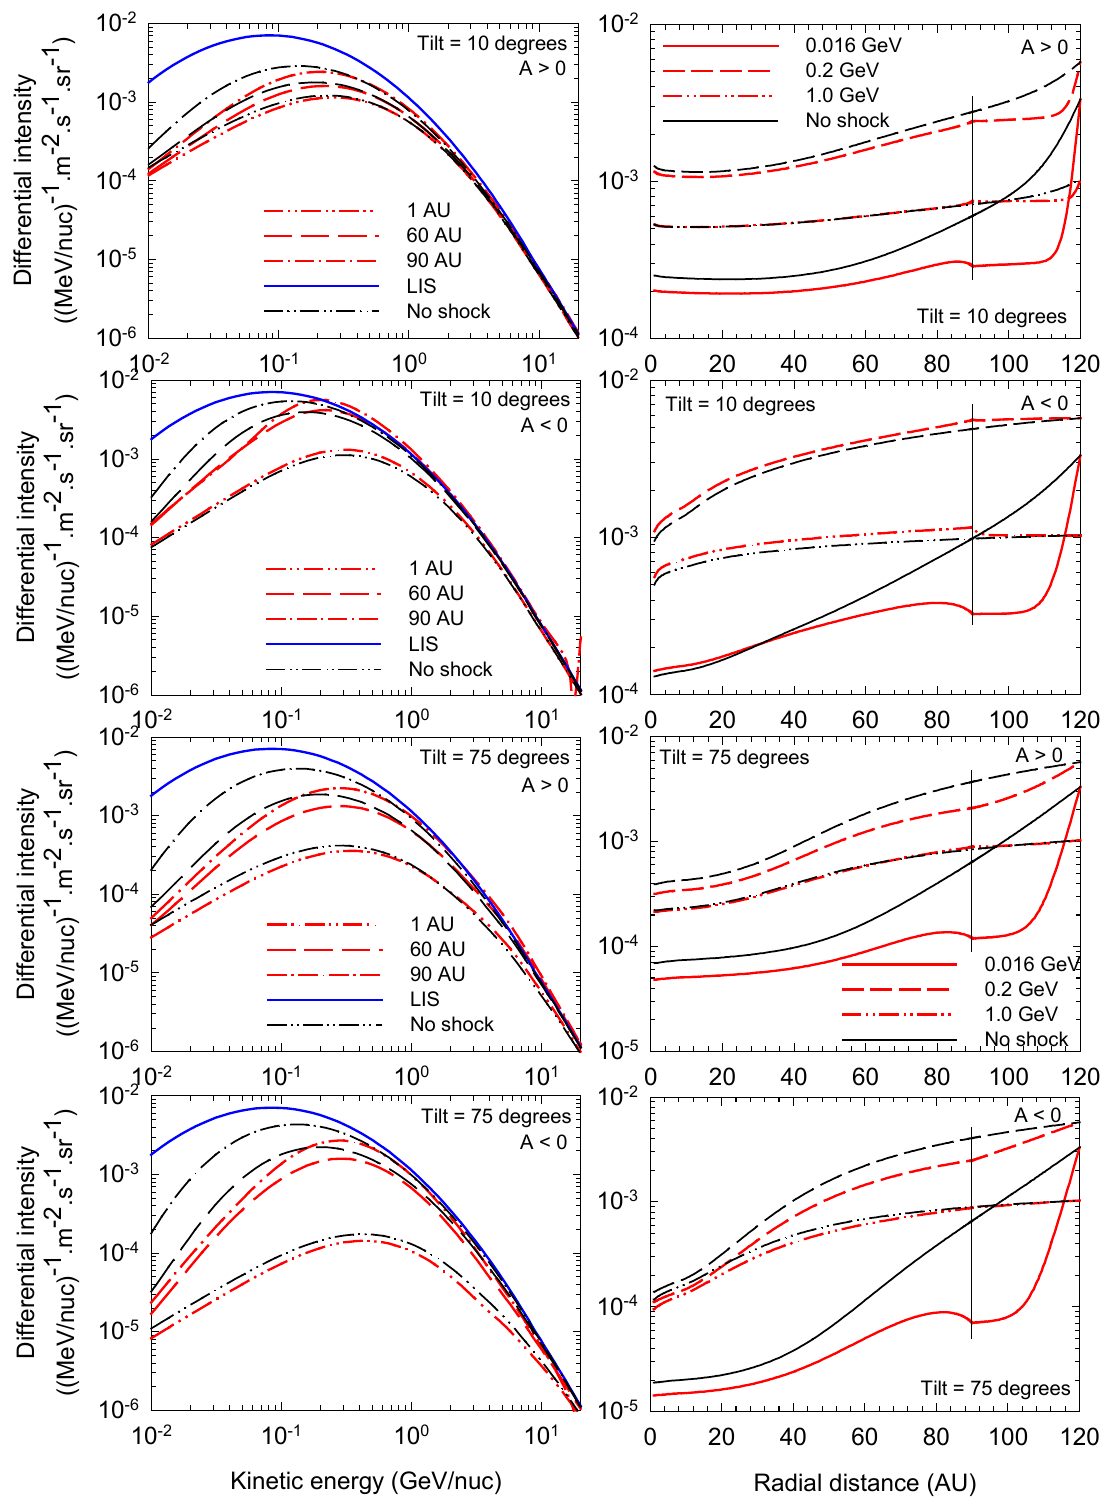
Fig. 1. Left panels: Computed differential intensities for galactic boron (B) as a function of kinetic energy for both polarity cycles, at radial distances of 1, 60, and 90 AU (bottom to top) in the equatorial plane. Right panels: The corresponding differential intensities as function of radial distance for 0.016, 0.2 and 1.0 GeV, respectively. In all panels the TS is at 90 AU, as indicated, with the IS (blue lines) specified at 120 AU, with α = 10 ° and 75 ° , respectively. Solutions without a TS in the model are given as black lines for the same radial distances and energies. Note the scale difference between some of the panels.